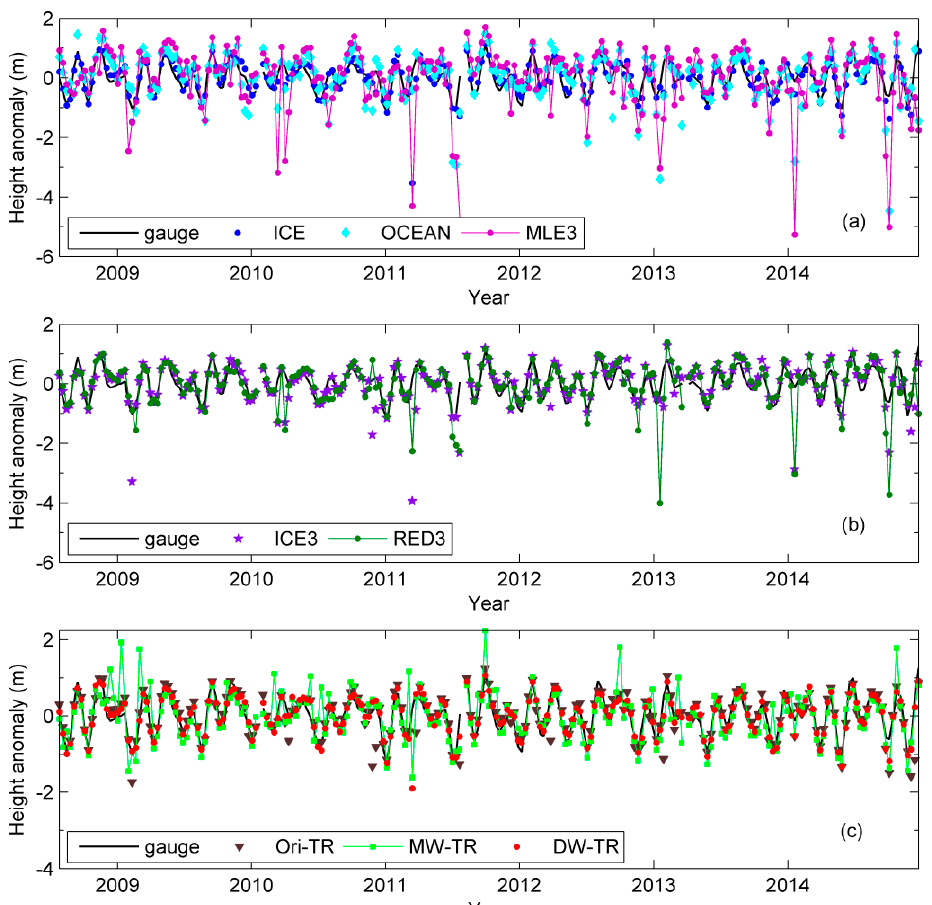
Figure 5. Coastal (0–10 km) SSH variation from different retrackers: ( a ) Sensor geophysical data record (SGDR) retrackers; ( b ) Prototype Innovant de Système de Traitement pour les Applications Côtières et l’Hydrologie (PISTACH) retrackers; ( c ) 20% threshold retrackers using original, modified and decontaminated waveforms near Los Angeles gauge station. Black line denotes tide gauge data.